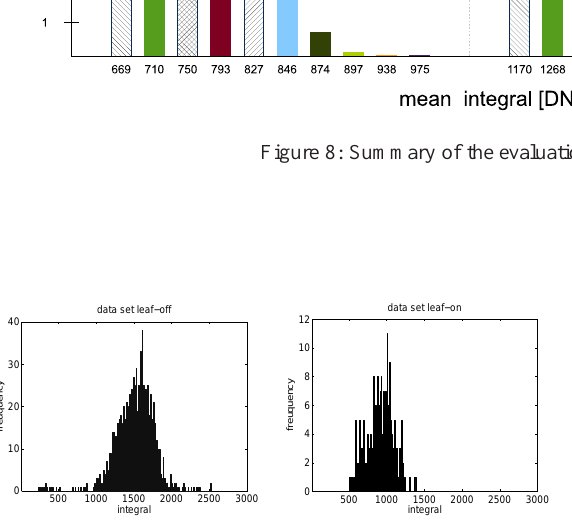
Figure 9: Histogram of the integrals of all eligable reference waveforms, left: leaf-off, right: leaf-on